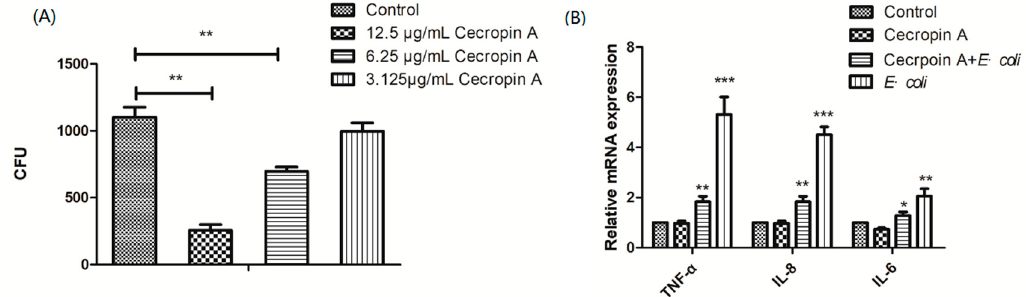
Figure 1. Cecropin A inhibited bacterial adherence and reduced the expression of inflammatory factors. The porcine jejunum epithelial cells (IPEC-J2) cells were pretreated with cecropin A (3.125, 6.25, and 12.5 μ g/mL) for 48 h, and the CFU of adherent bacteria were counted (( A ), n = 3). The relative mRNA expression of TNF - α , IL - 8 , and IL - 6 were tested by using qPCR (( B ), n = 6). Control: control group; cecropin A: cells were pretreated with cecropin A; cecropin A + E. coli : cells were pretreated with cecropin A and then cocultured with E. coli ; E. coli : cells cocultured with E. coli . The results were confirmed by three independent experiments per treatment. Representative results of the three independent experiments are shown. Data (mean ± SEM) were analyzed with one-way ANOVA. * p < 0.05, ** p < 0.01, *** p < 0.001.